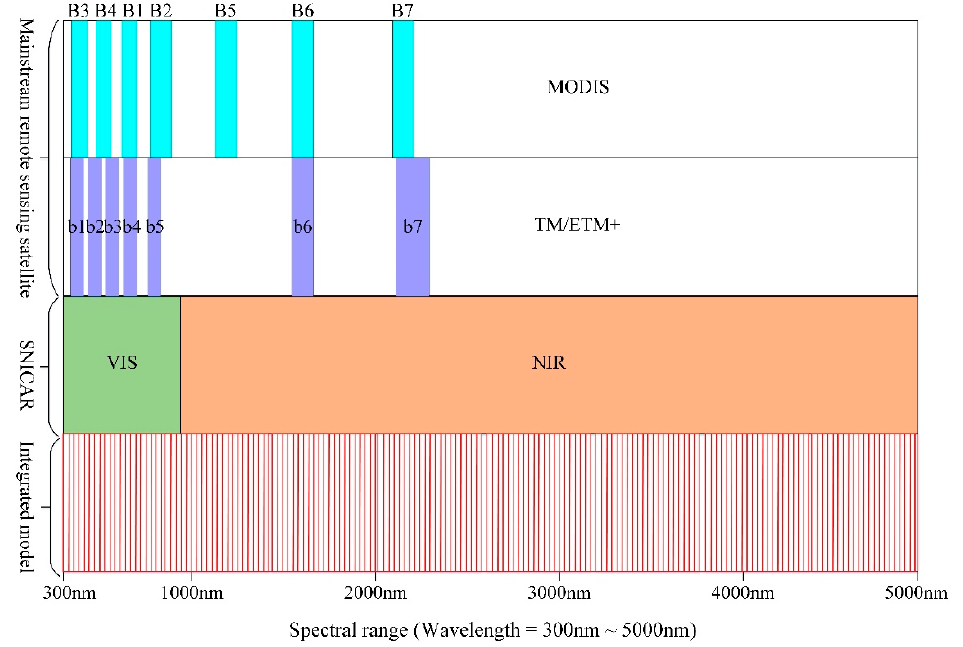
Figure 11. Comparison of the ranges of snow spectral albedo that can be obtained by the new integrated model, the Snow, Ice, and Aerosol Radiative (SNICAR) model, and mainstream remote sensing satellites (B1 (620–670 nm), B2 (841–876 nm), B3 (459–479 nm), B4 (545–565 nm), B5 (1230–1250 nm), B6 (1628–1652 nm), and B7 (2105–2155 nm) are MODIS observation bands; b1 (430–450 nm), b2 (450–510 nm), b3 (530–590 nm), b4 (640–670 nm), b5 (850–880 nm), b6 (1570–1650 nm), and b7